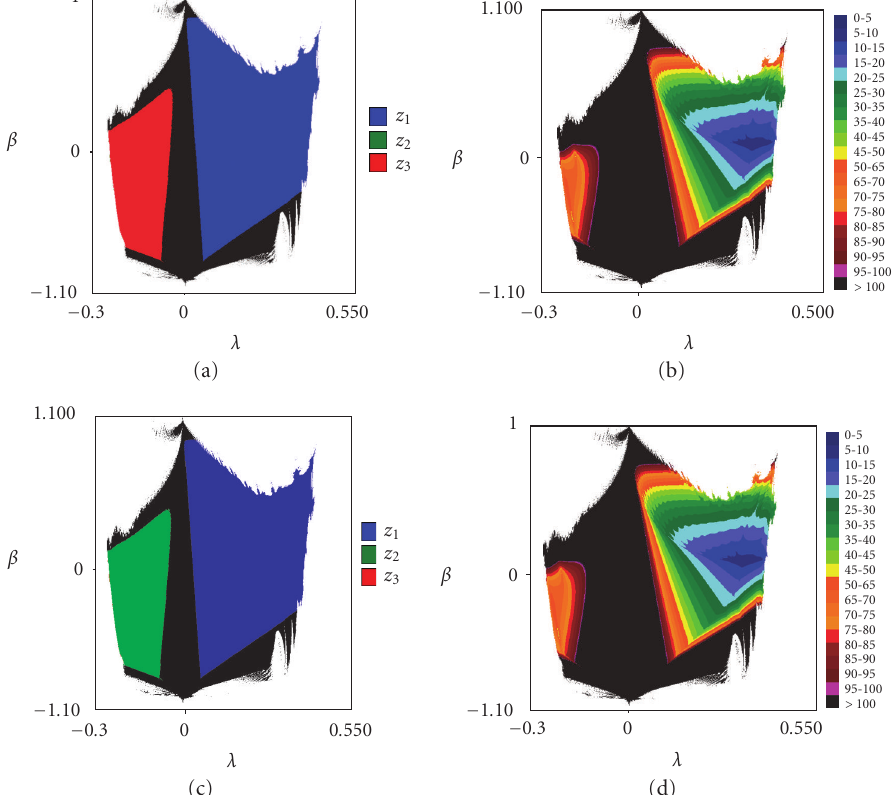
Figure 4.6. Bifurcations diagram of GCG method in ( λ , β )-plane with the following starting points: (a)–(b) z 0 = − 1 . 2+ i · 0 . 1, (c)–(d) z 0 = − 1 . 2 − i · 0 .